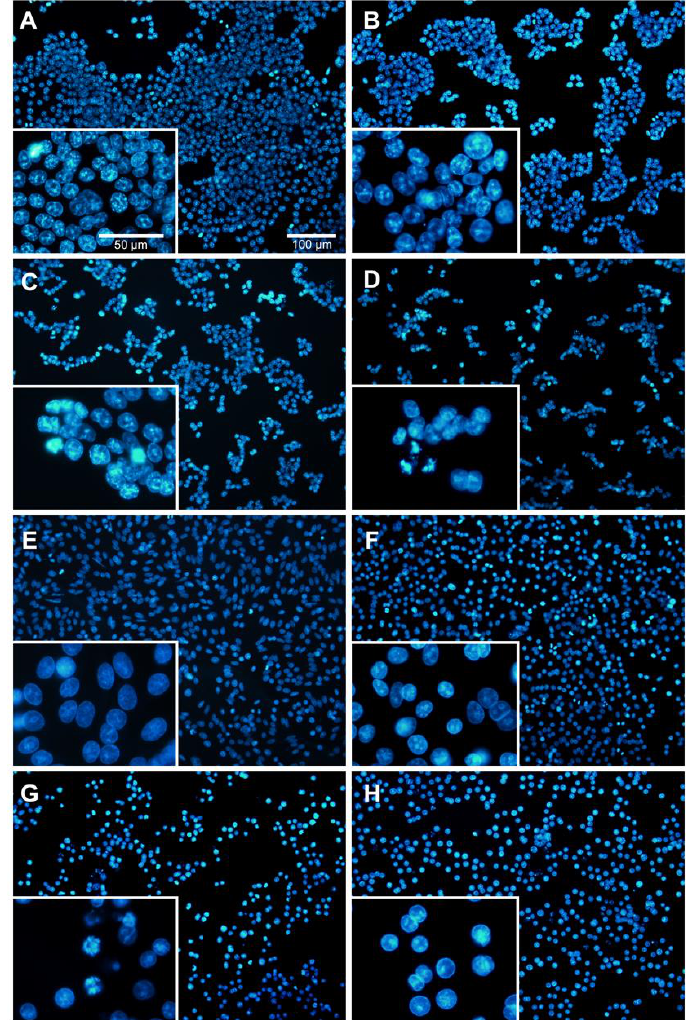
Figure 4. Nuclear morphology of BA-treated HCT116 ( A – D ) and SW480 ( E – G ) human colorectal cancer cells at 24 h using Hoechst staining. Different concentrations of BA were used, including 0, ( A ) 1.25, ( B ) 2.5, ( C ) and 5 µM ( D ) for HCT116; and 0, ( E ) 2.5, ( F ) 5 ( G ) and 10 µM ( H ) for SW480 cells. Cells were observed under 100 X and 50 X magnification using a fluorescence